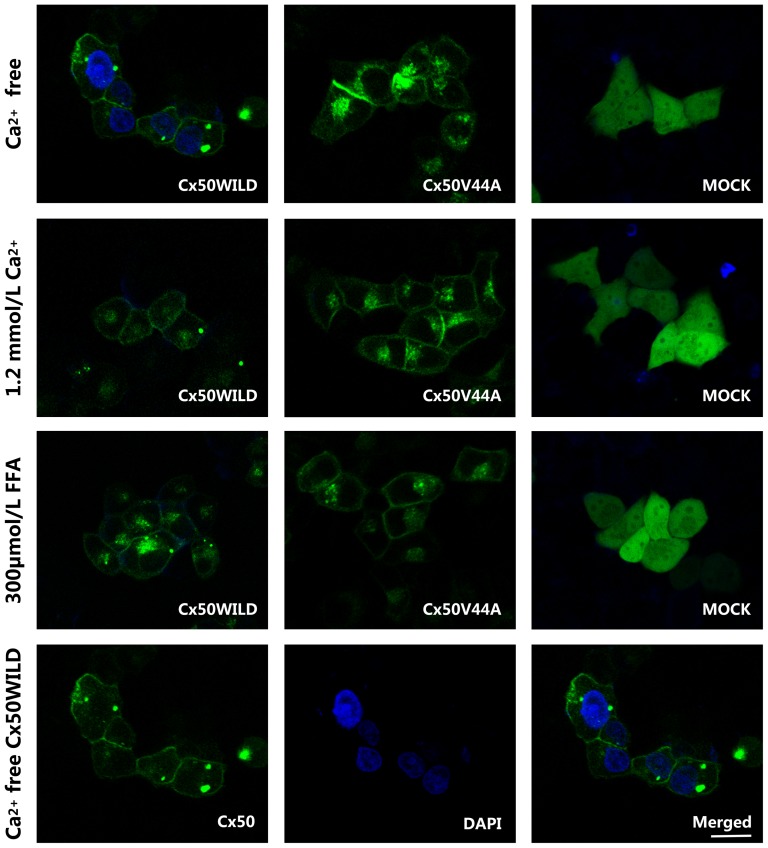
DAPI dye uptake in HeLa cells stably transfected with Cx50WILD and Cx50V44A.DAPI was abosorbed by most of the Cx50WILD-transfected cells, but not by the Cx50V44A- and pEGFP-N1-transfected cells (Mock), after hemichannel opening. DAPI loading in Ca2+-free HBSS was blocked by 1.2 mM Ca2+ and 300 µM FFA. The three pictures in the last line show the Cx50 protein, DAPI-stained nuclei and merged look of the wild-type cells in Ca2+-free HBSS. Scale bar: 20 µm.